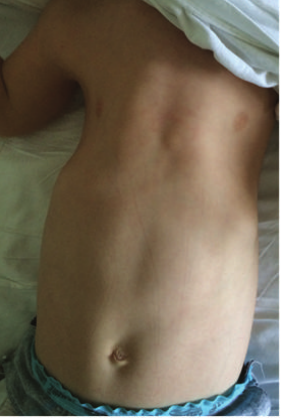
Figure 1: Narrow, long rib cage.